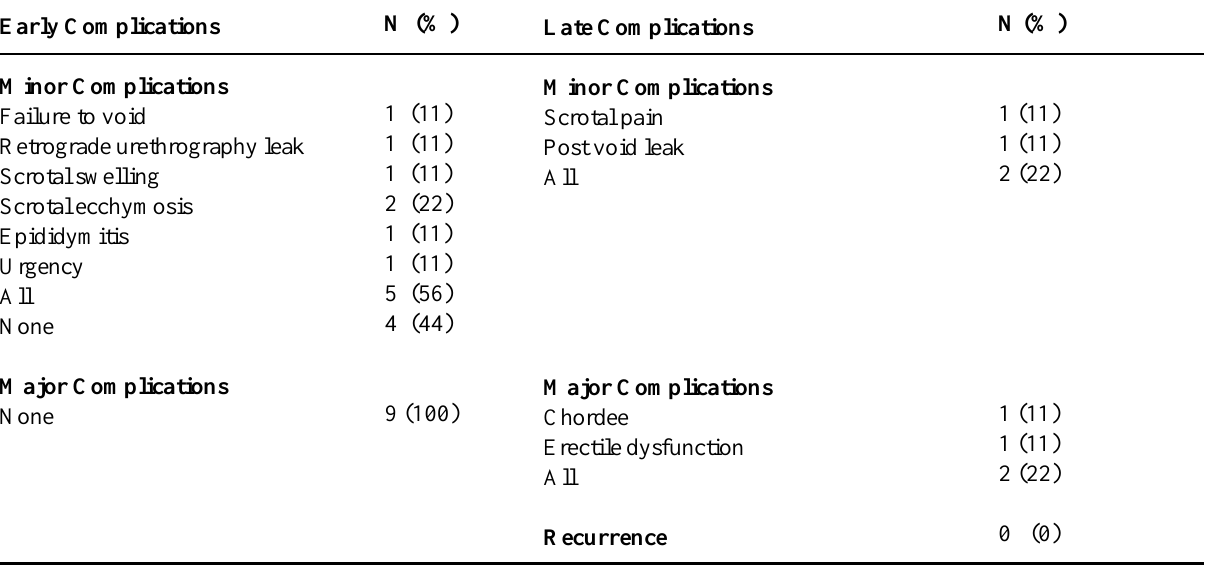
Table 3 – Posterior anastomotic urethroplasty complications, n =